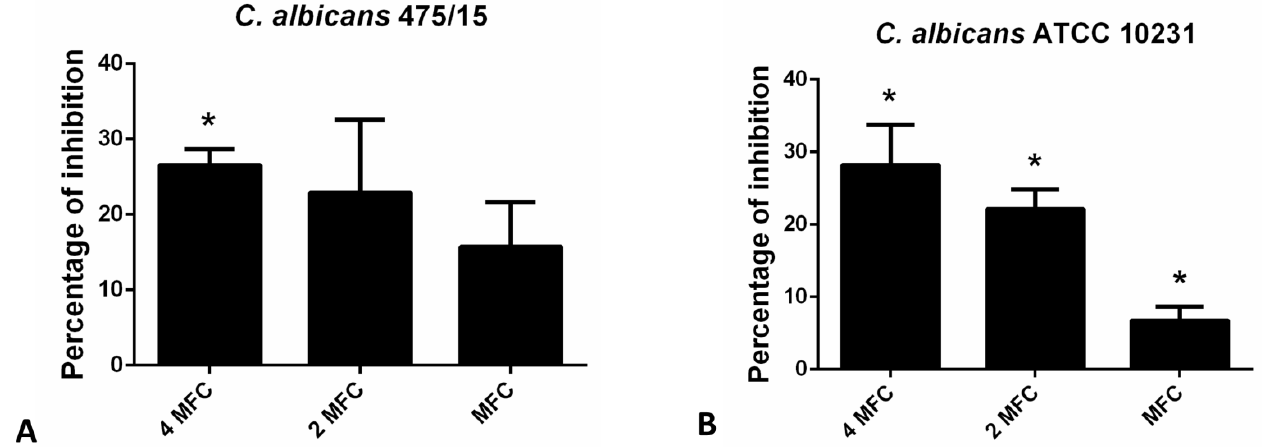
Figure 4. Inhibition of biofilm matrix exopolysaccharides as determined in the Congo red binding assay for ( A )- C. albicans 475/15; ( B )- C. albicans ATCC 10231 after application of hesperetin in concentrations MFC (0.330 mg/mL), 2 MFC (0.660 mg/mL) and 4 MFC (1.320 mg/mL). Mean values of triplicate independent experiments ± SD are shown, * p < 0.05 compared to control.